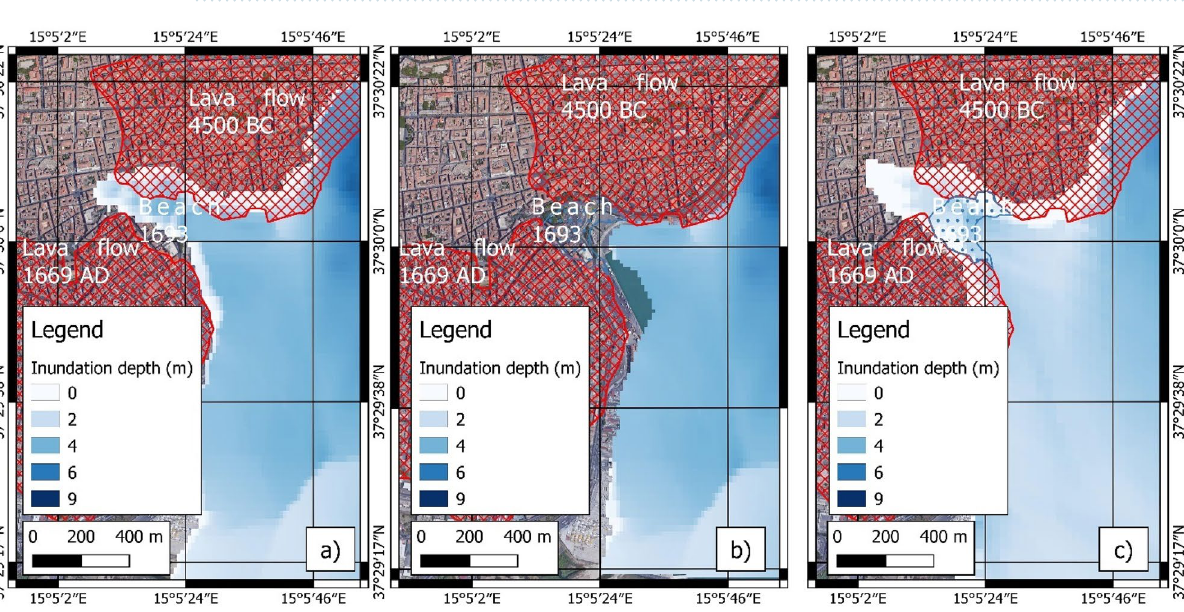
Figure 13. Modelling of tsunami inundation in the Catania area; ( a ) SFS scenario; ( b ) SLS scenario; ( c ) DTS scenario. The maps were obtained by co-authors through QGIS—software (version 3.14.16); https:// www.